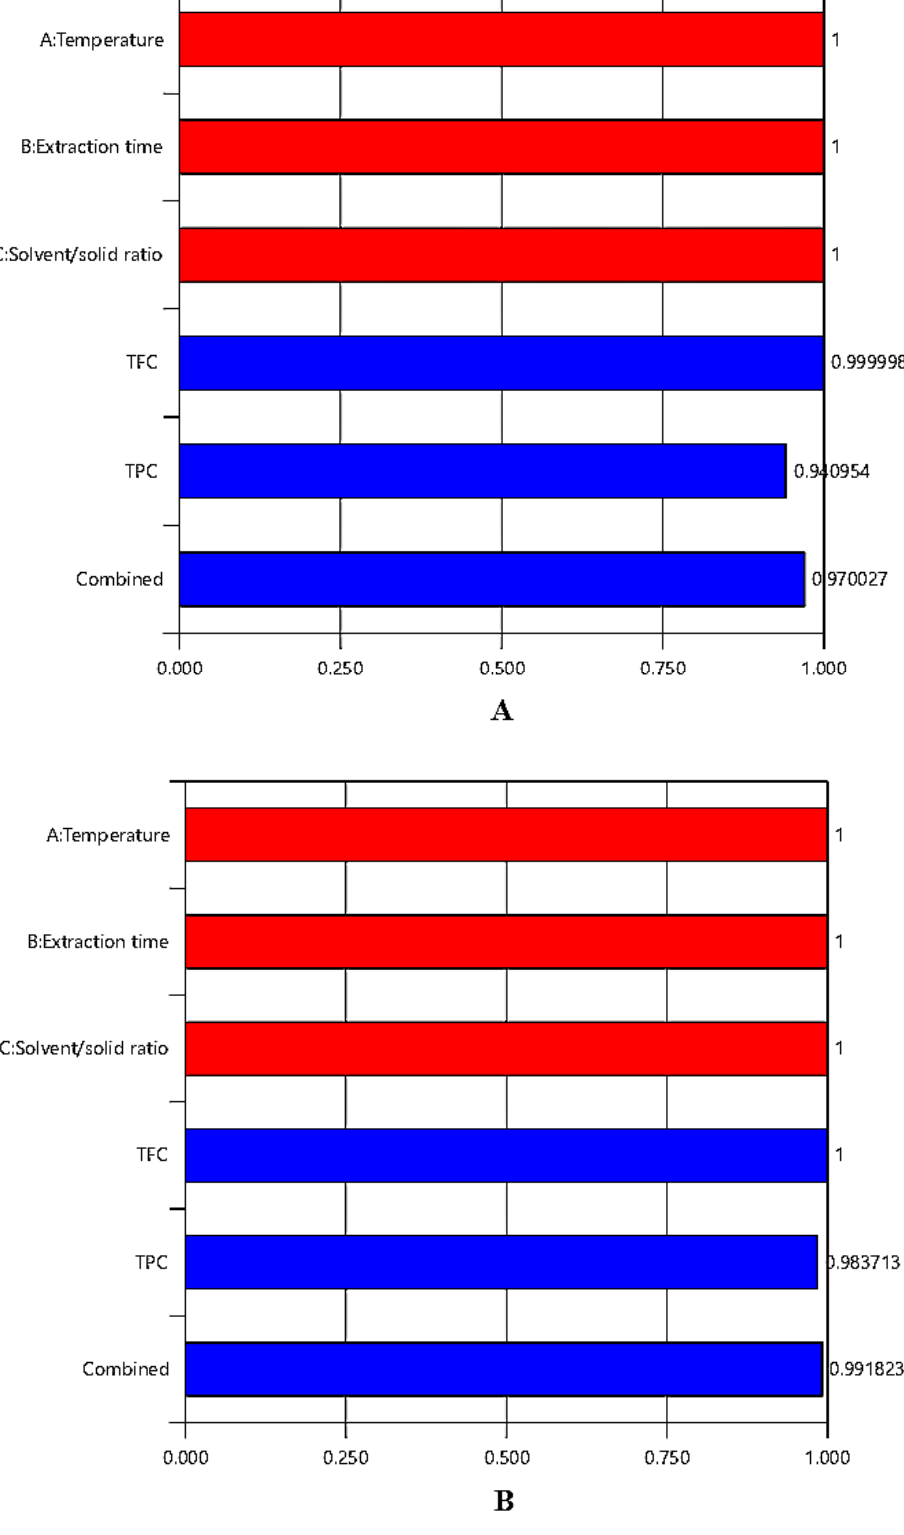
Figure 3. Desirability graphs for the independent variables and the corresponding responses individually and the combined response effect for A − optimization extraction of ethanol extract and B − optimization extraction of acetone